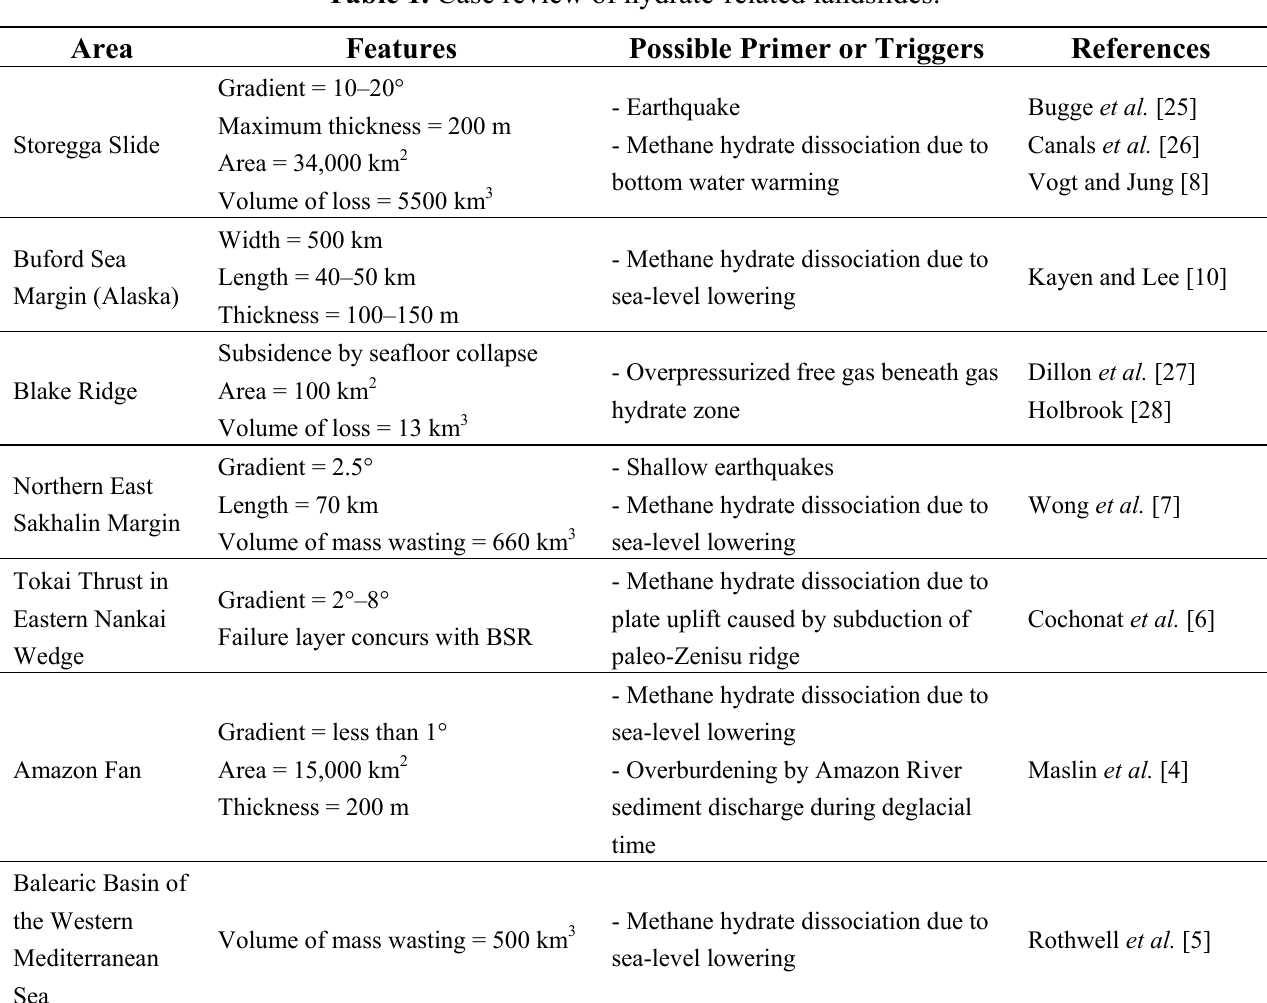
Table 1. Case review of hydrate-related